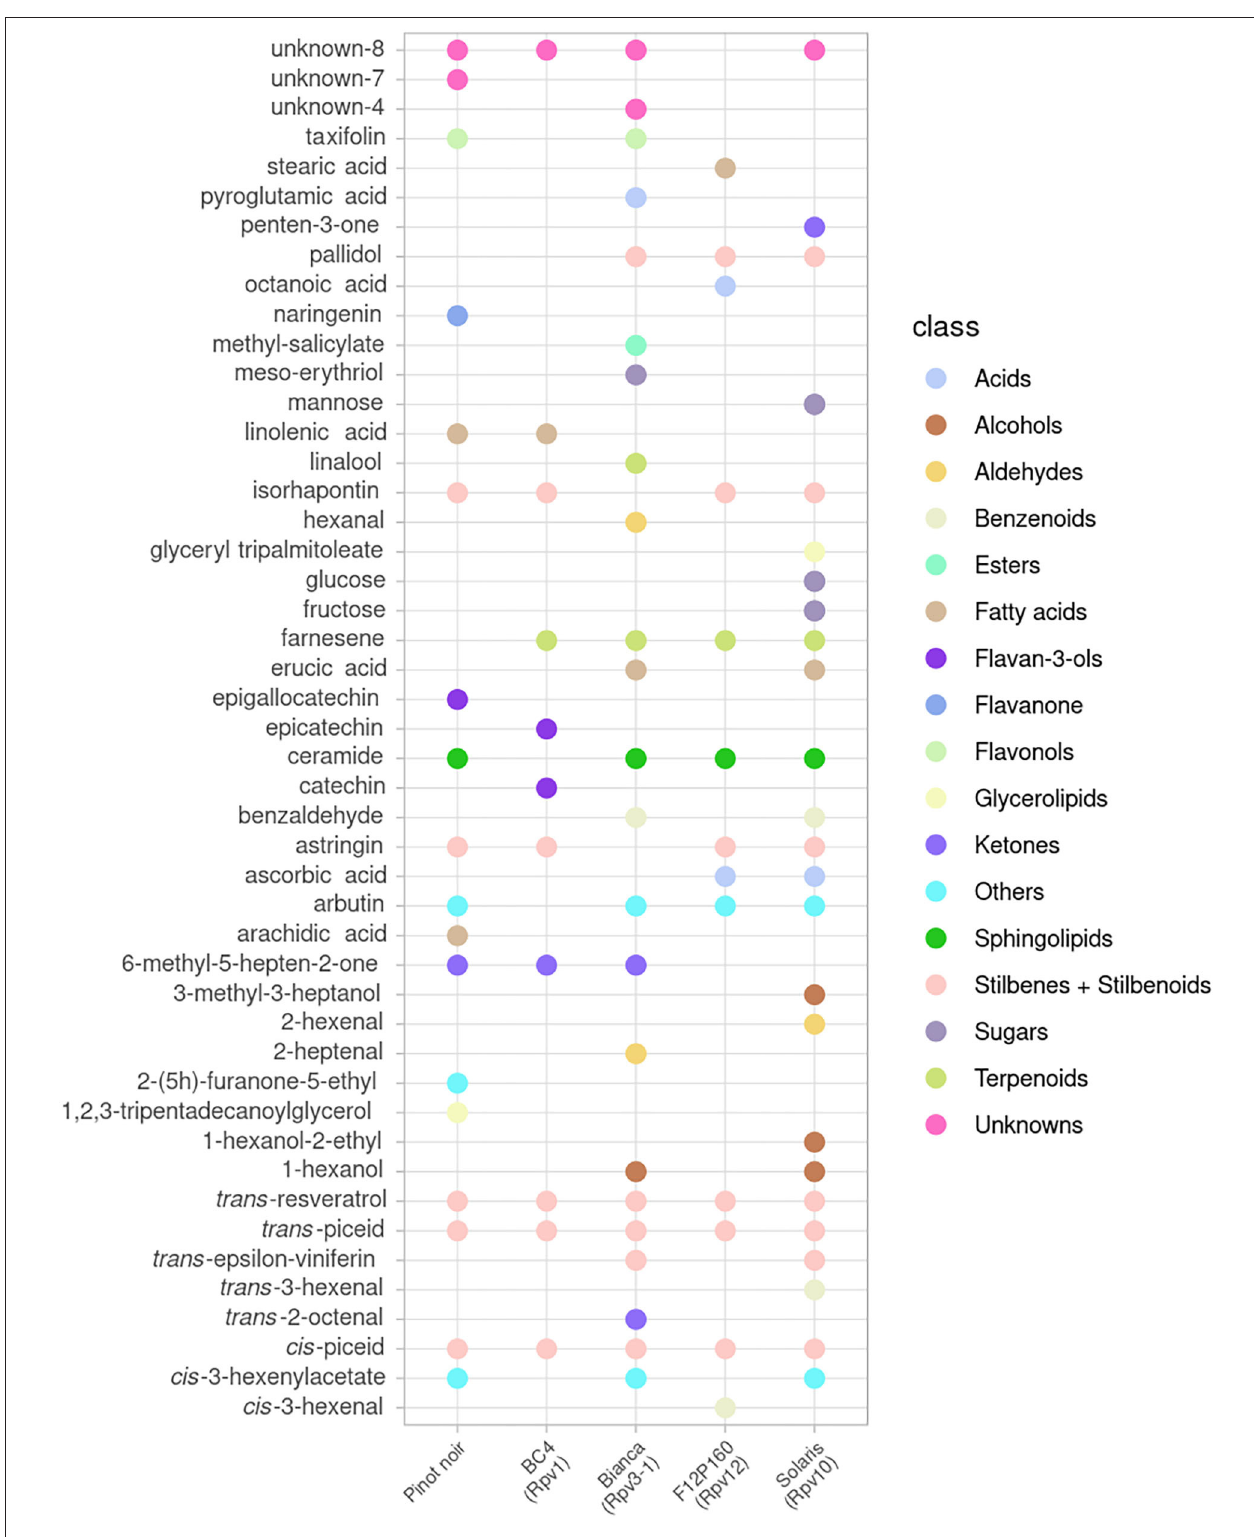
FIGURE 2 | Metabolites significantly modulated by the infection in at least one-time point for mono-locus resistant genotypes (BC4, Bianca, F12P160, Solaris) and for the susceptible Pinot Noir. All time points were considered in the 2 years of data analysis (2016–2017) and the color of each metabolite identifies the different chemical